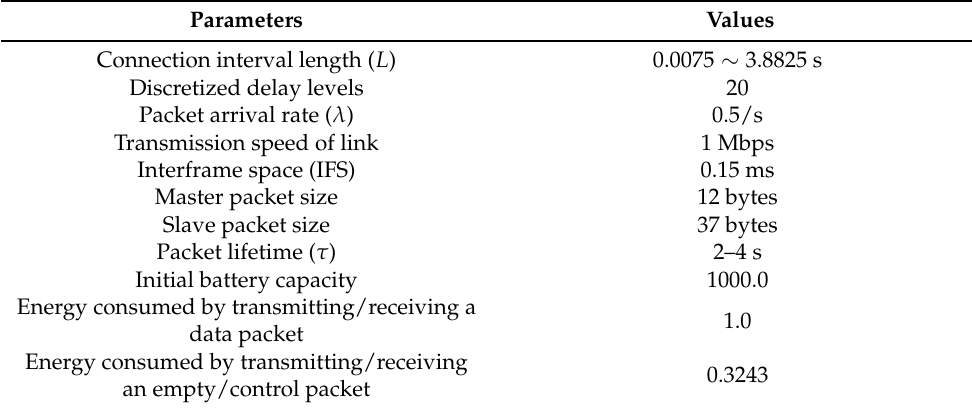
Table 1. Parameters used in the numerical